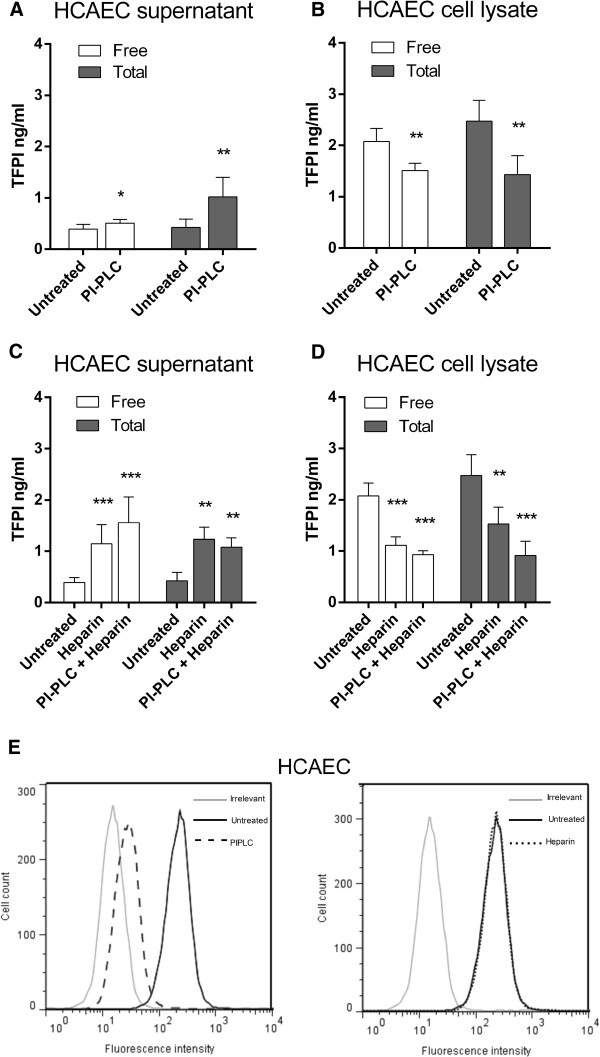
PI-PLC and heparin treatment of HCAEC cells. Serum-starved cells were treated with SFM (untreated), PI-PLC (1 U/mL), or heparin (5U/mL) for 2 hours or with PI-PLC + heparin (2+2 hours) before the supernatant was removed and cells lysed or collected for flow cytometry analysis. The supernatant was discarded after PI-PLC pre-treatment. Total and free TFPI antigen measured in the supernatant (A and C) and cell lysate (B and D) of untreated/PI-PLC (A and B) and untreated/heparin/PI-PLC+heparin (C and D) treated HCAEC cells. Mean values (n ≥ 5; supernatant, n = 4; cell lysate) + SD of two independent experiments. Statistical comparisons were conducted between PI-PLC or heparin/PI-PLC+heparin treated samples and untreated controls. (E) Flow cytometry analysis of untreated (black, solid), PI-PLC (black, broken, left panel), and heparin (black, dotted, right panel) treated HCAEC cells. One representative experiment of three is shown.